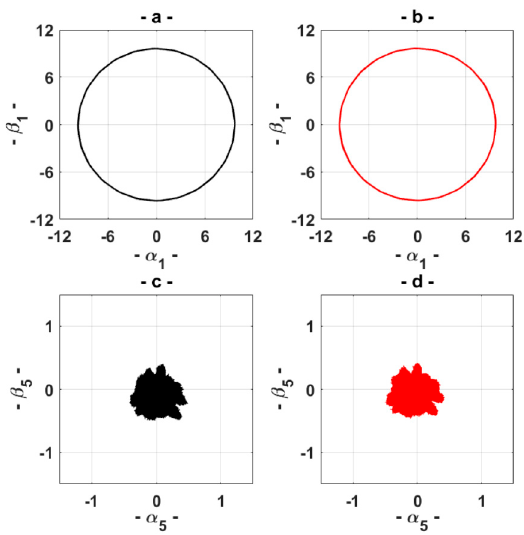
Figure 8. Experimental results: behavior of the drive using the proposed IFOC. Loci of the current space vector on plane α 1 – β 1 , under ( a ) healthy and ( b ) HRC (R add = 0.7 pu). Loci of the current space vector on plane α 5 – β 5 , under ( c ) healthy and ( d ) HRC (R add = 0.7 pu).